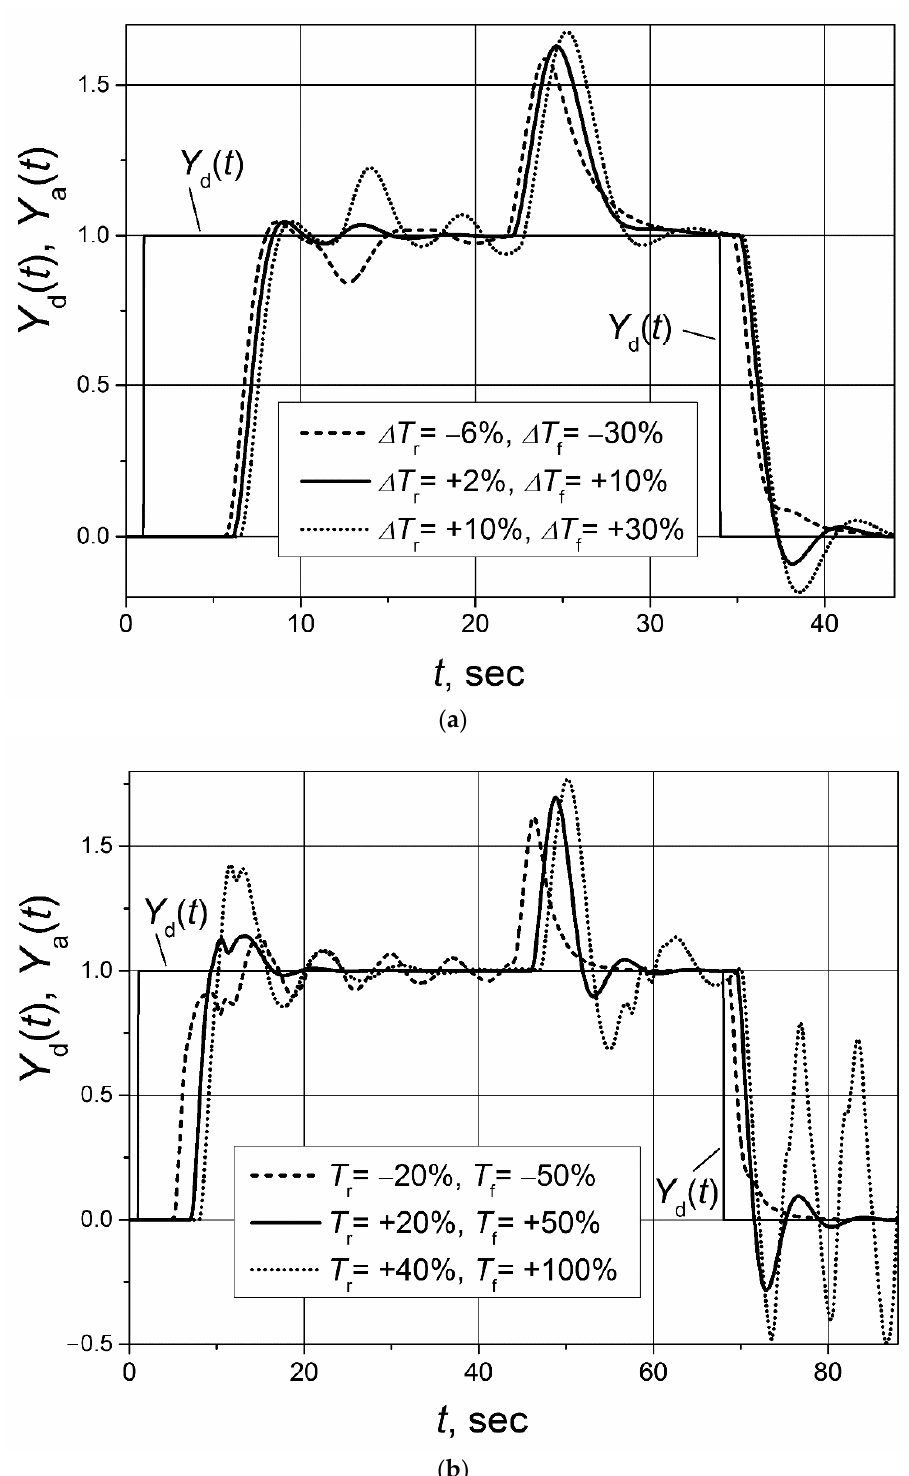
Figure 12. The set-point unit pulse and unit-load disturbance responses of the control system of the second-order plant with asymmetric response delay based on the PI controller with the switched- delay Smith predictor when both plant-response delays change: T r changes by value ∆ T r and T f by value ∆ T f . Unit-load disturbances occur at times: ( a ) t = 17 s; ( b ) t = 40 s.